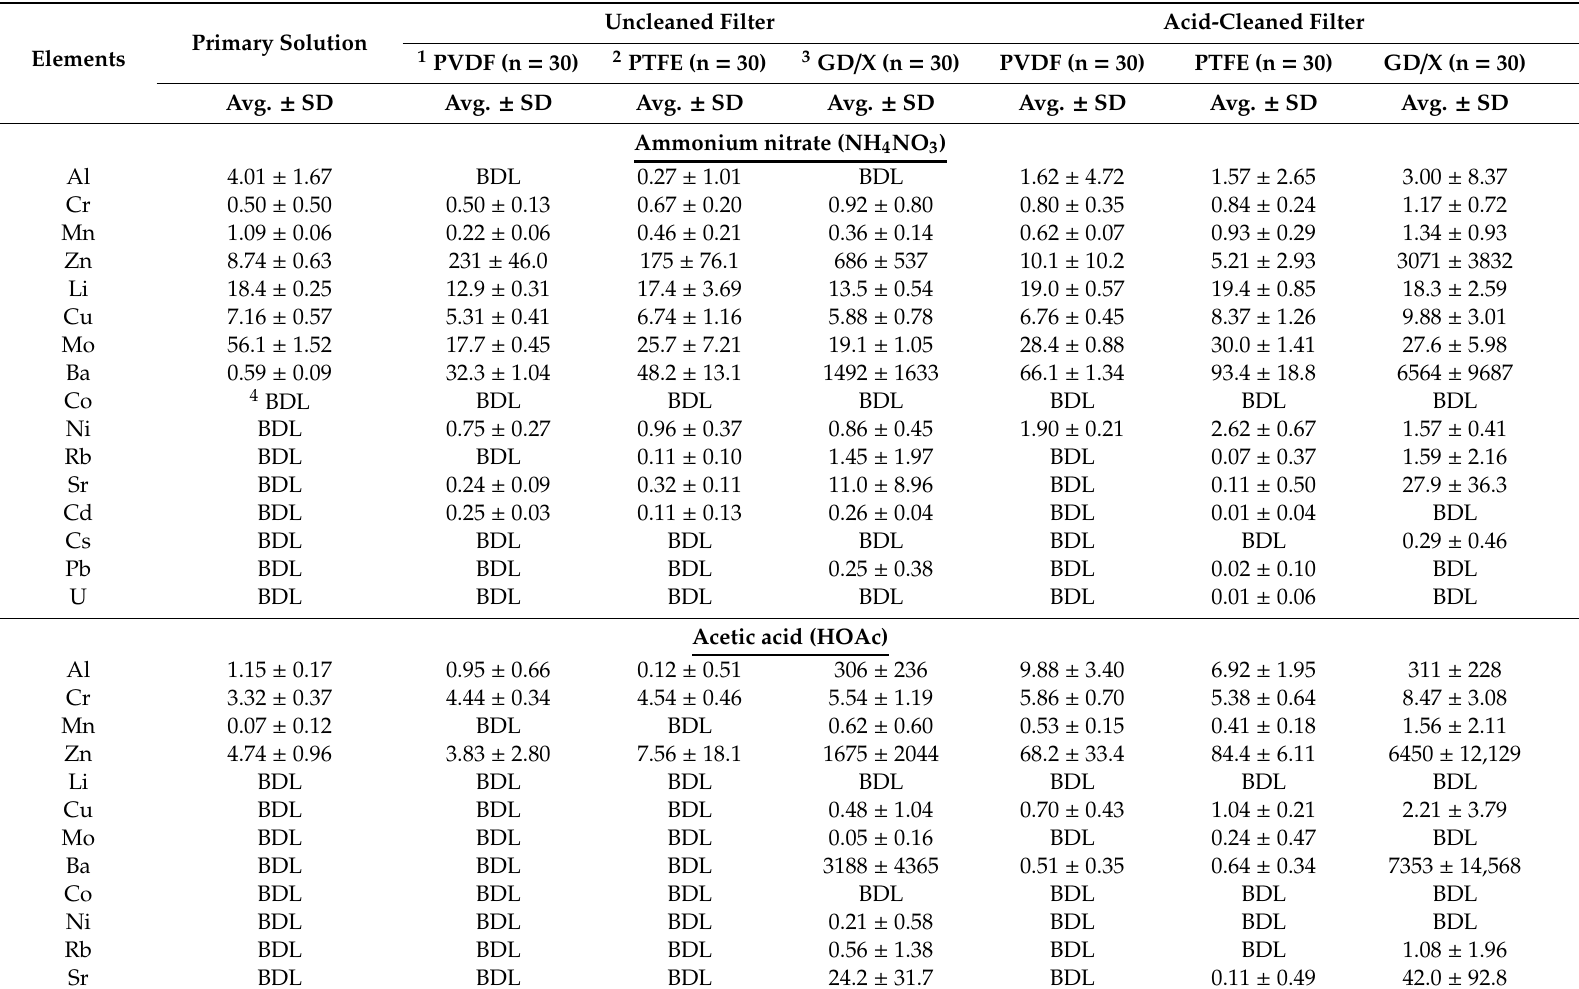
Table 1. Concentrations of trace elements in ammonium nitrate and acetic acid extracted from three uncleaned and acid-cleaned types of filters (unit in µ g L − 1 ).